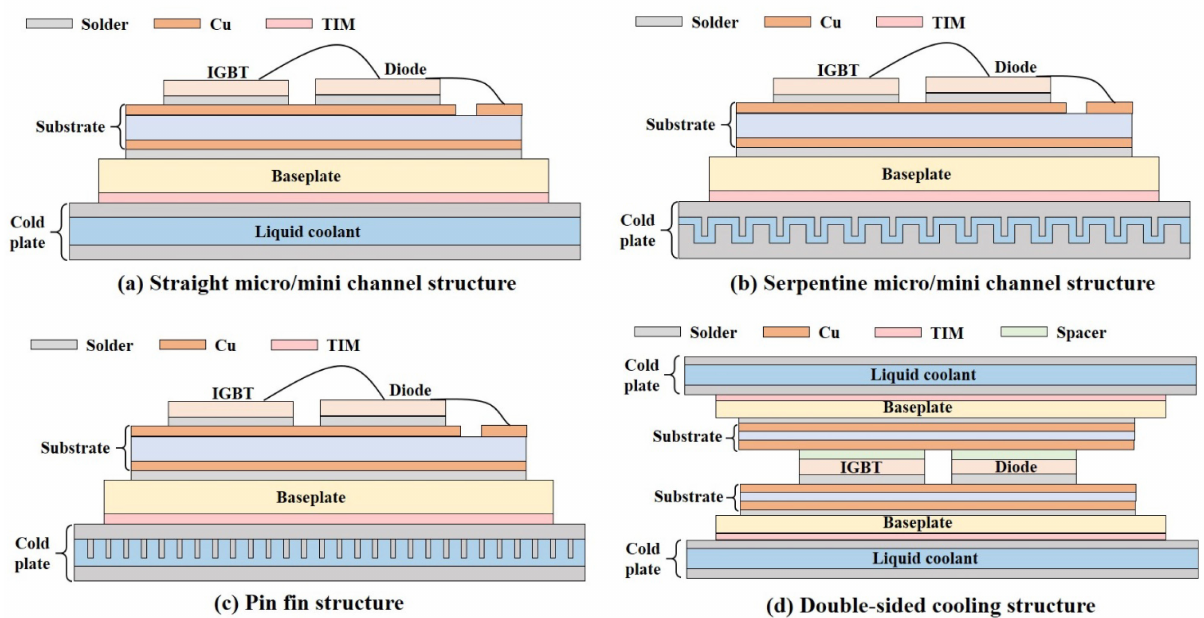
Figure 5. Schematics of different types of cold plate [36].